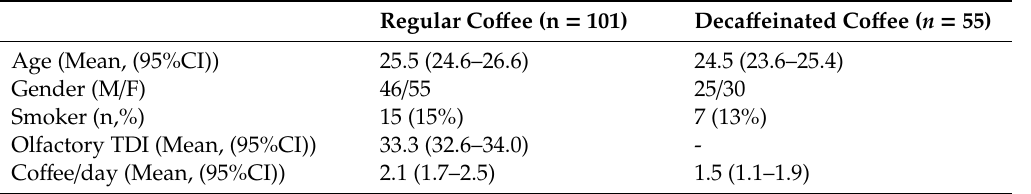
Table 1. Demographic data for the cohorts “Regular co ff ee”—primary study—and “Deca ff einated co ff ee”—exploratory study. 95%CI: 95% confidence interval; TDI: threshold,